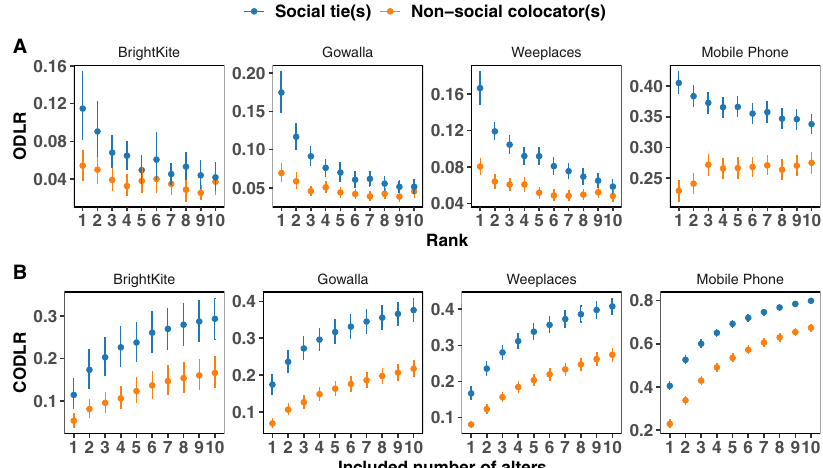
Fig. 4 The degree of ego – alter distinct location overlap. A The Overlapped Distinct Location Ratio (Eq. 5) indicates that higher ranked alters share more unique location visits than lower-ranked ones, with the top (rank-1) alter showing the most shared location. The trend is stronger for social ties than non- social colocators. B The Cumulative Overlapped Distinct Location Ratio (Eq. 6) shows increasing discovery of unique locations in the ego ’ s trajectory as alters are added in order of decreasing rank, but that the rate of discovery slows. Error bars denote 95% CI.